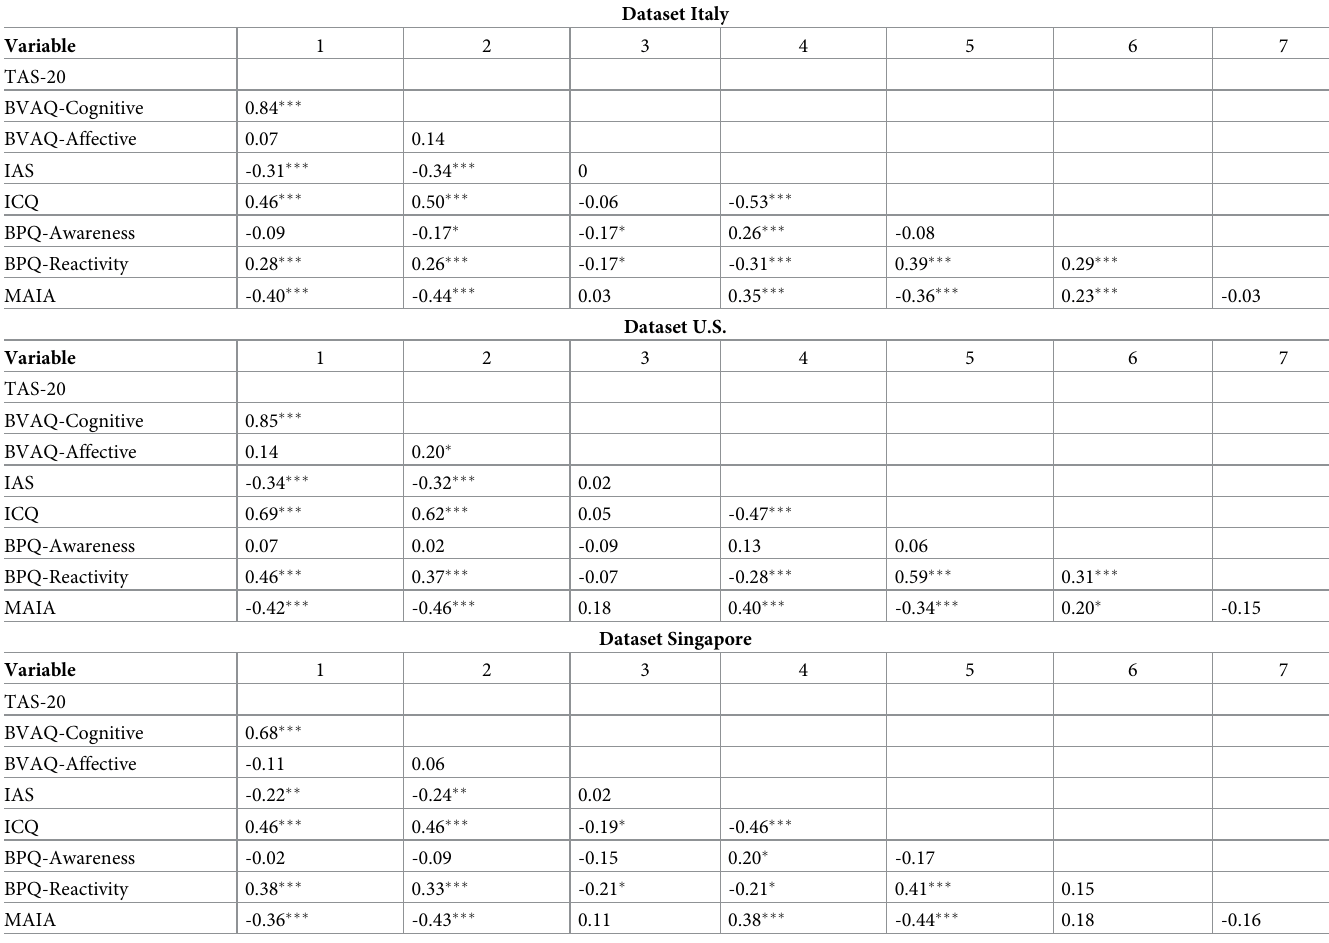
Table 3. Correlation matrices p < .05, �� p < .01, ��� p < .001.